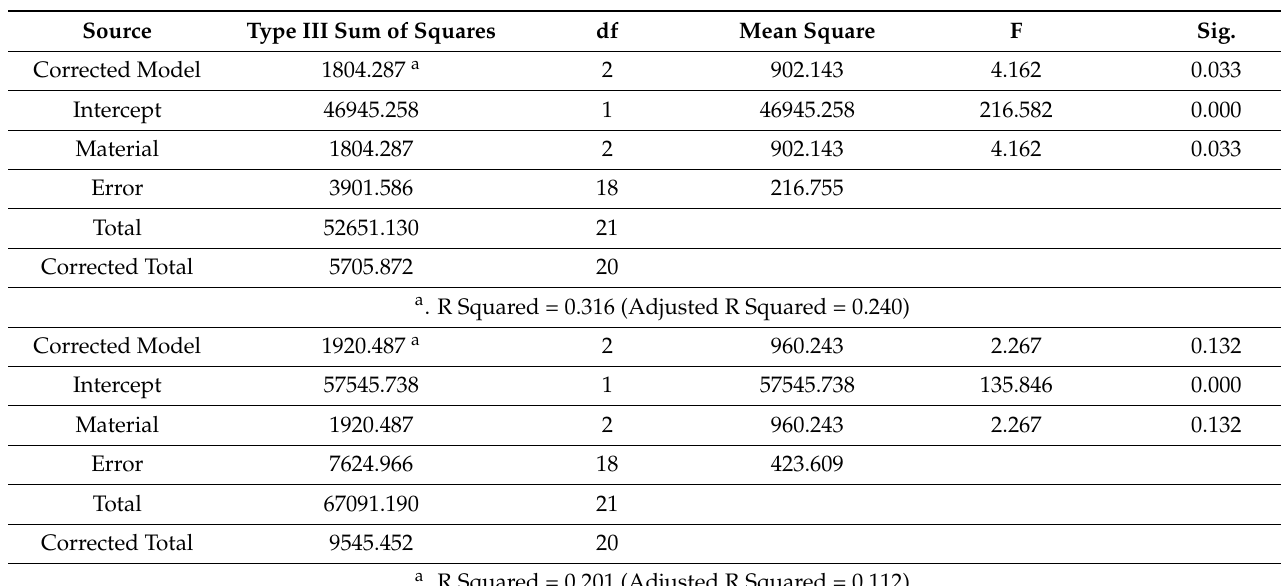
Table 7. ANOVA test of material effect 0.25 mm and 0.50 mm.